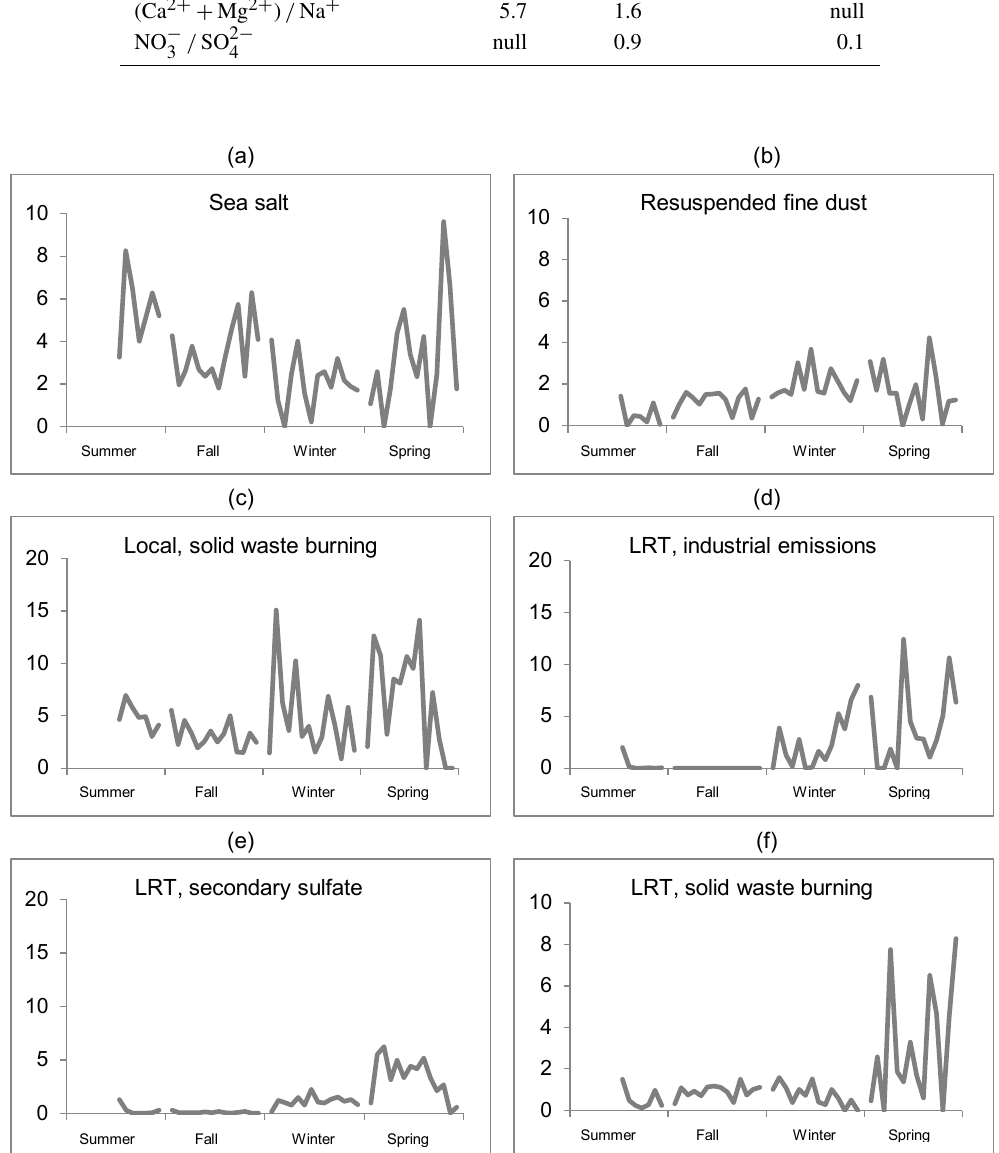
Figure 11. Daily contribution for each source profile: (a) sea salt; (b) resuspended fine dust; (c) local, solid waste burning; (d) LRT, industrial emissions; (e) LRT, secondary sulfate; and (f) LRT, solid waste burning for all sampling periods (unit is µgm − 3